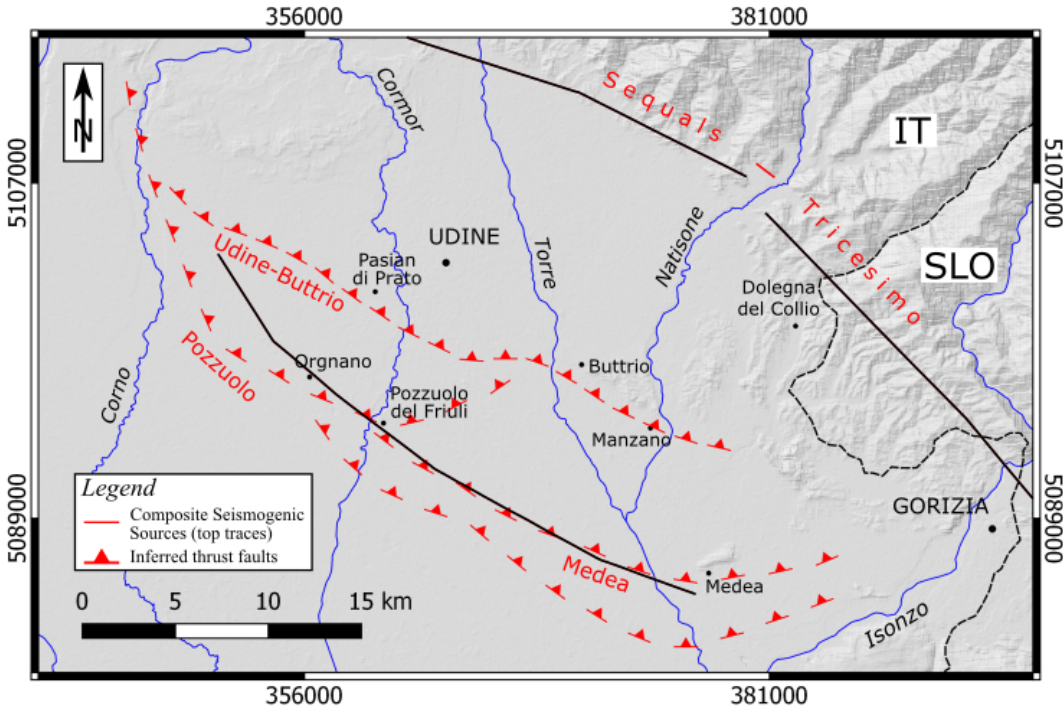
Figure 2. Structural sketch of the area between Udine and Gorizia. Locations of the inferred thrust faults are taken from the geologic map of the Friuli-Venezia Giulia region [22]. The black segments represent the composite seismogenic